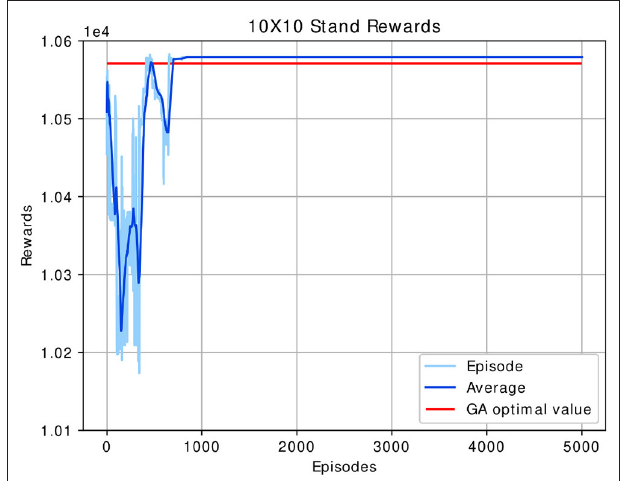
10 stands case compared ×